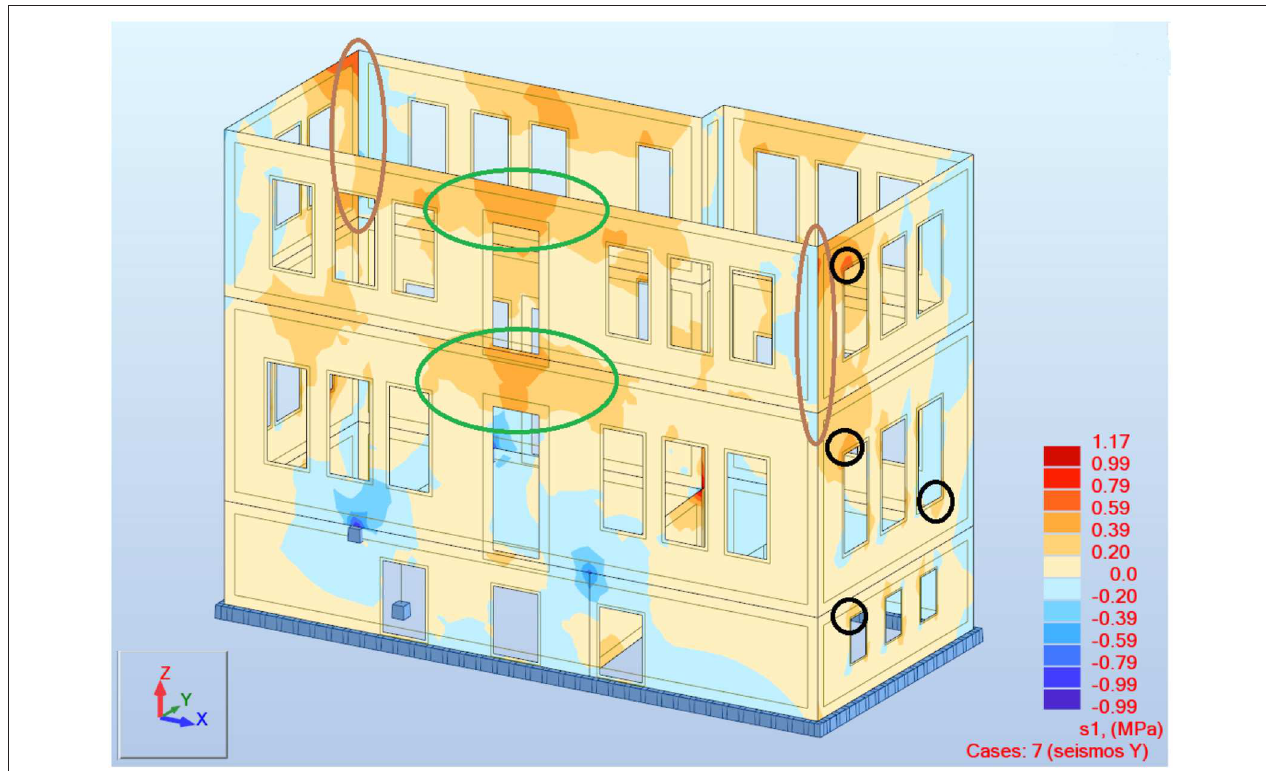
FIGURE 7 | Results of principal stresses (MPa) for seismic action in the y direction according to the First Greek Seismic Code (Royal Decree on the Seismic Code for Building Structures, 1959 ).